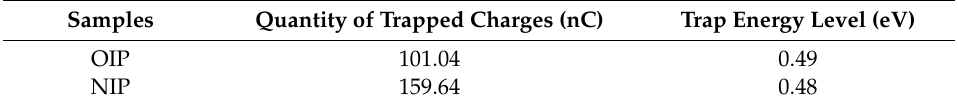
Table 4. The trap parameters of NIP and